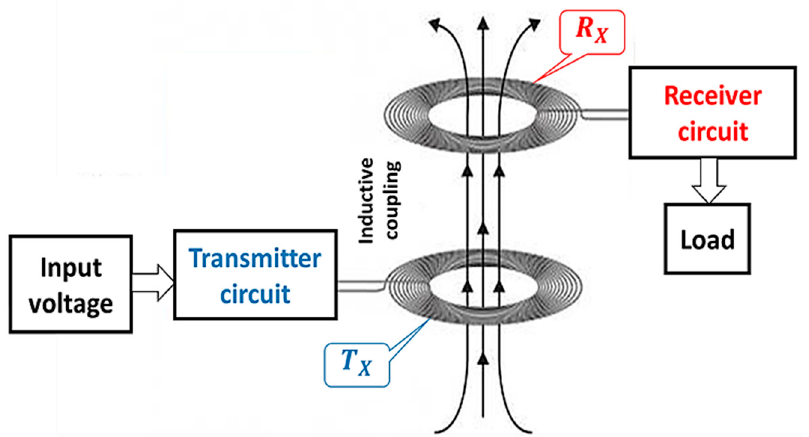
Figure 3. Inductive coupling between two circular coils.